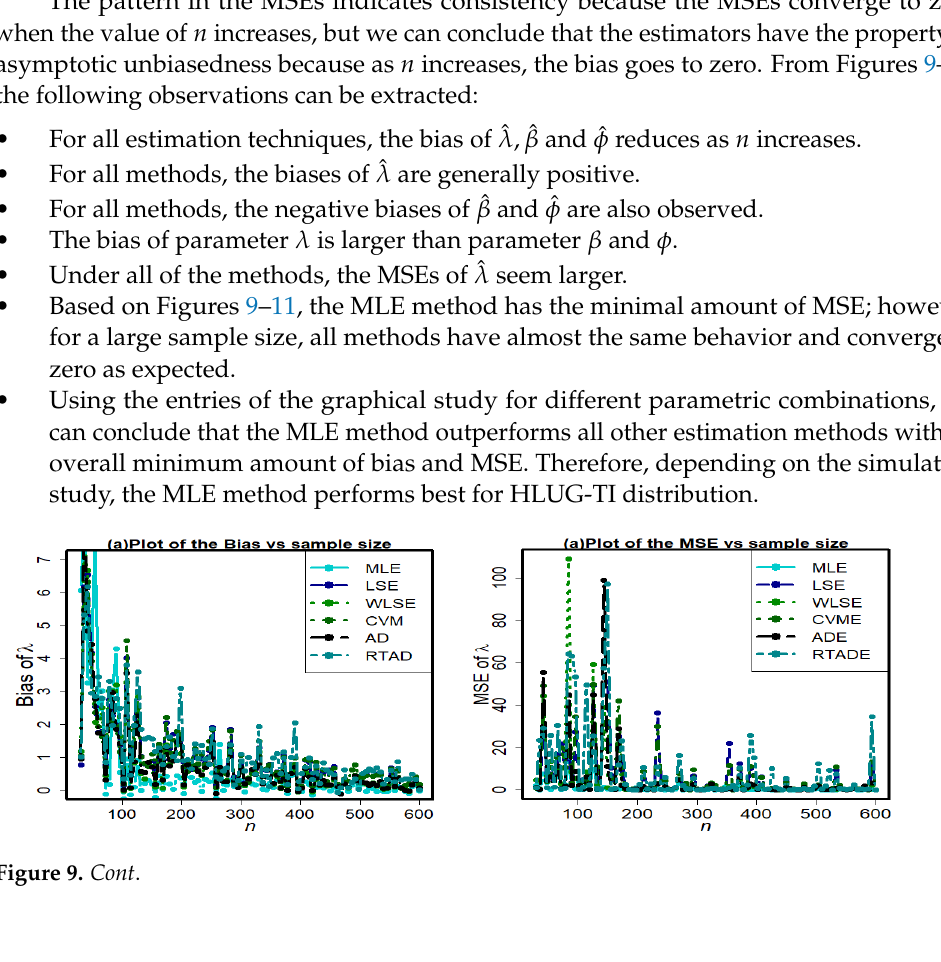
Fig. 9. Plots of biases and MSEs for the parameters (cid:21) = 1 : 5 ; (cid:12) = 1 : 3 and (cid:30) = 1 : 2 of HLUG-TI model.